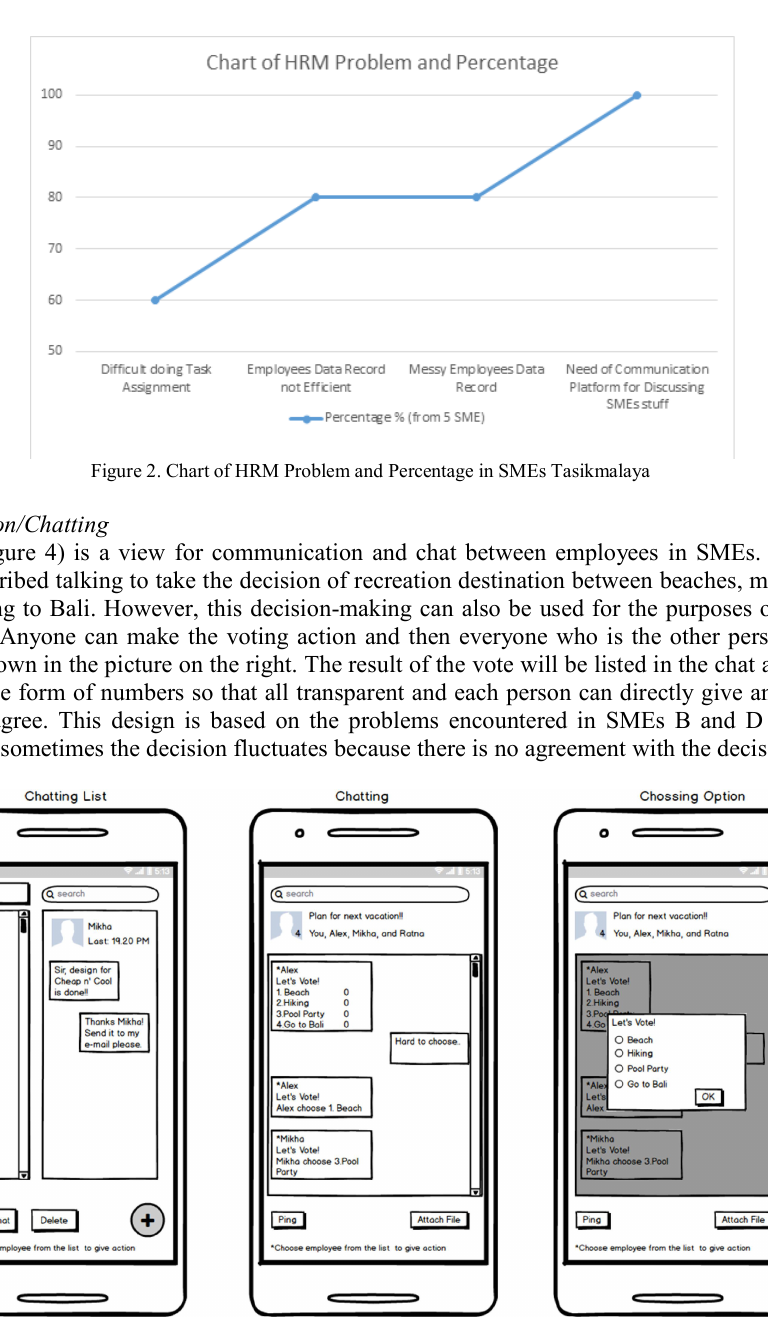
Figure 3. Communication